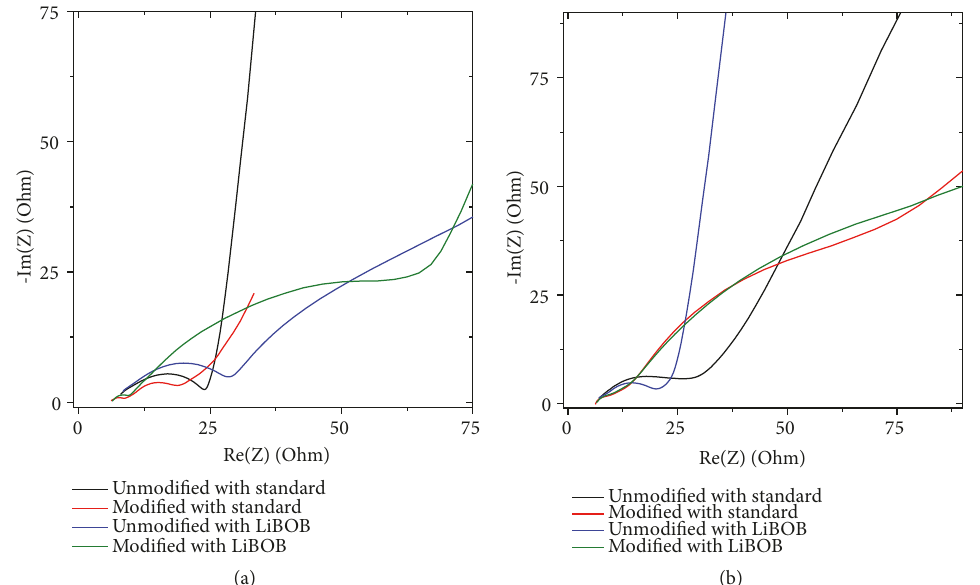
Figure 2: Impedance measurements of PA modified and unmodified LNMO electrodes in graphite full cells with and without LiBOB (a) after the formation cycle and (b) after 56 cycles.